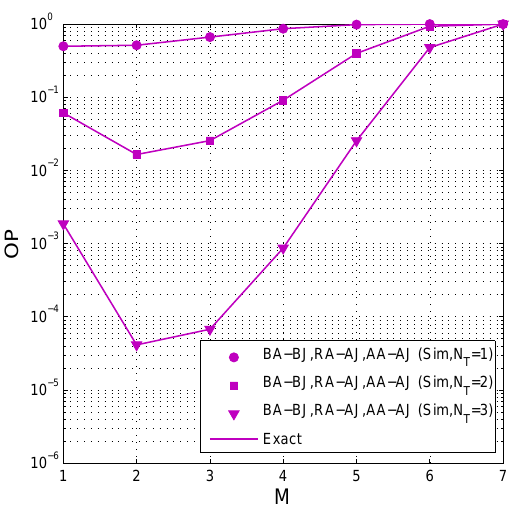
, Figure 6. OP as a function of µ 2 th = 1 . 5 0 . 65 , N T = 2 , K = 4 and M = 5 .